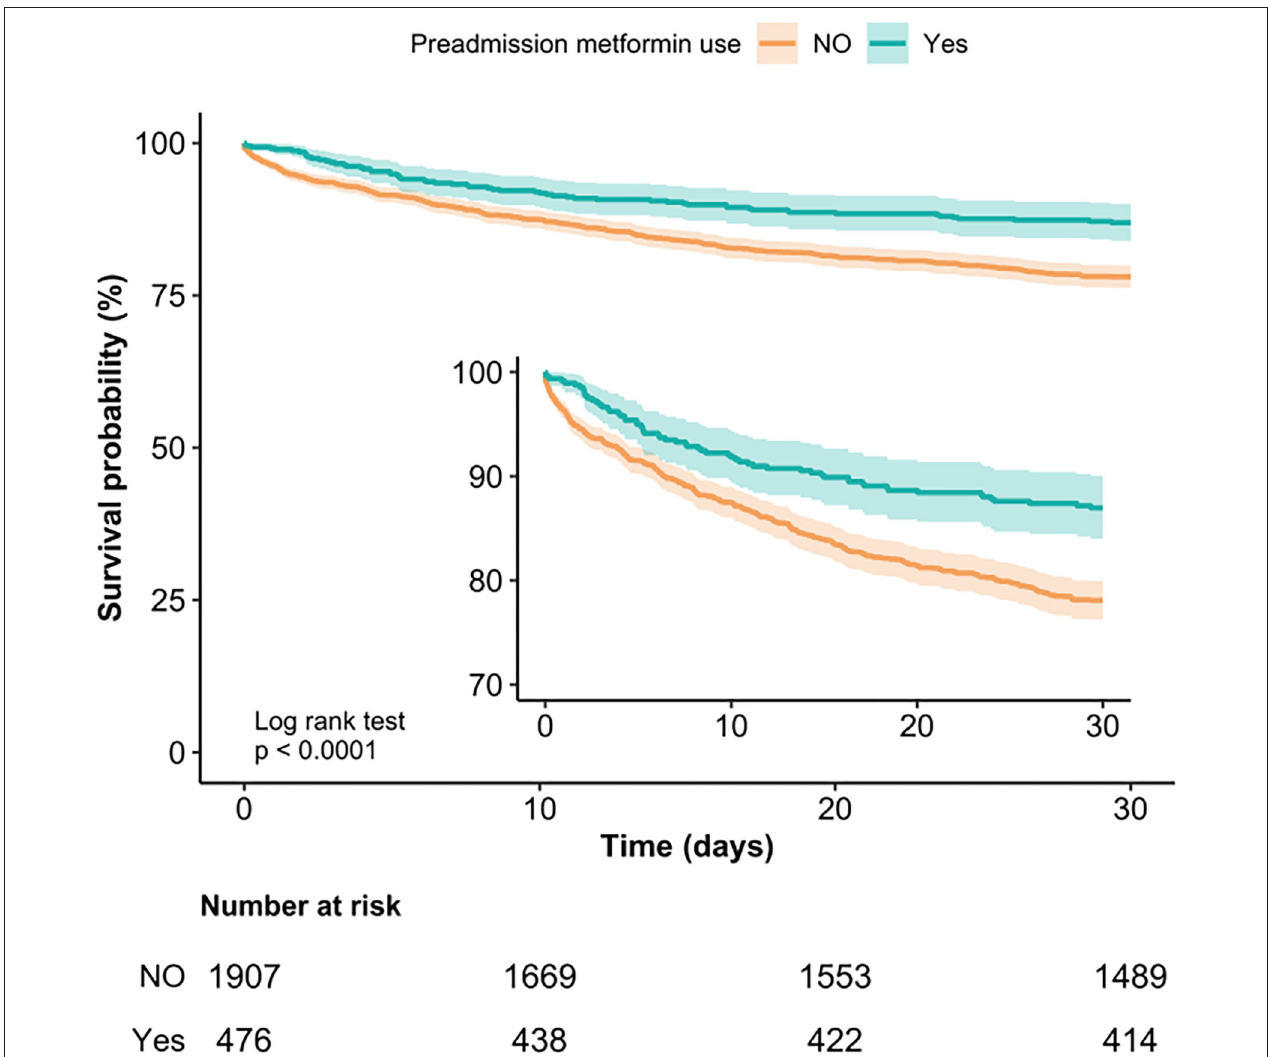
FIGURE 2 | Kaplan-Meier Survival Curves for day 30 of sepsis patients with type 2